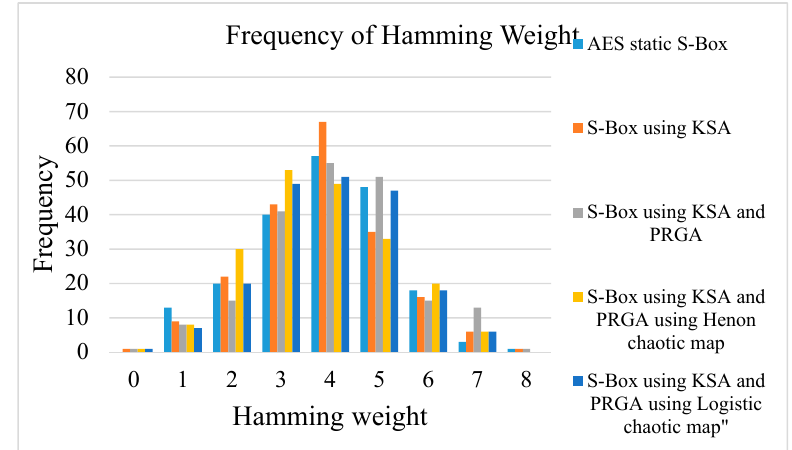
Figure 5. Hamming weights: A comparison between the five S-Boxes.